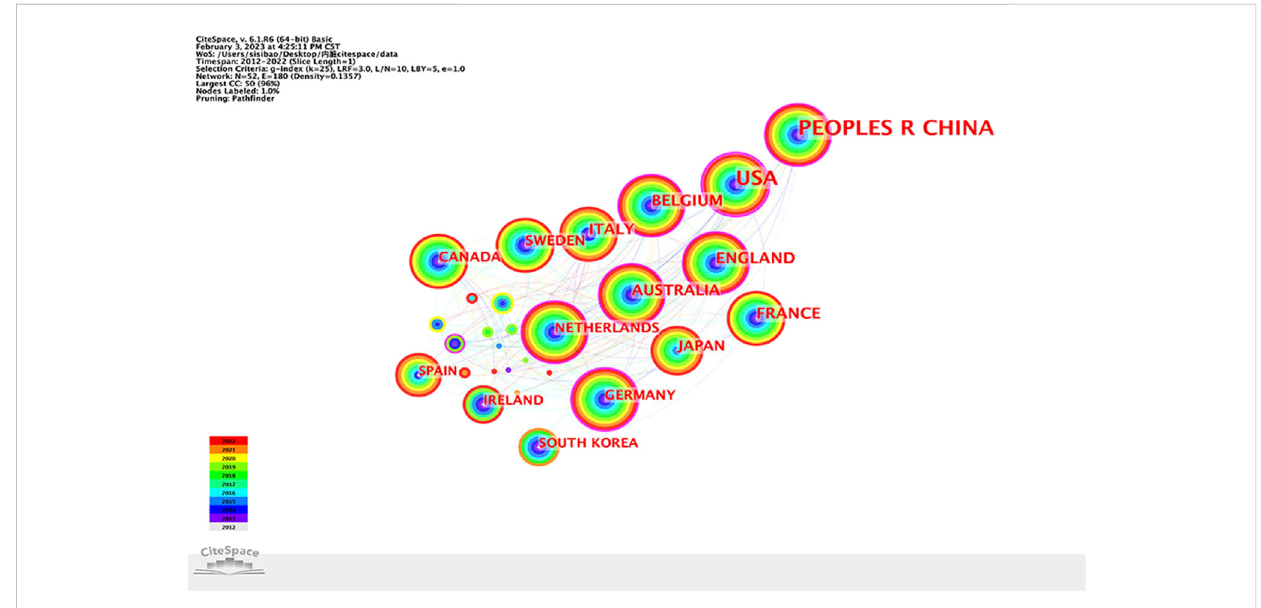
FIGURE 3 Country/region collaboration network of research on IBS and the visceral